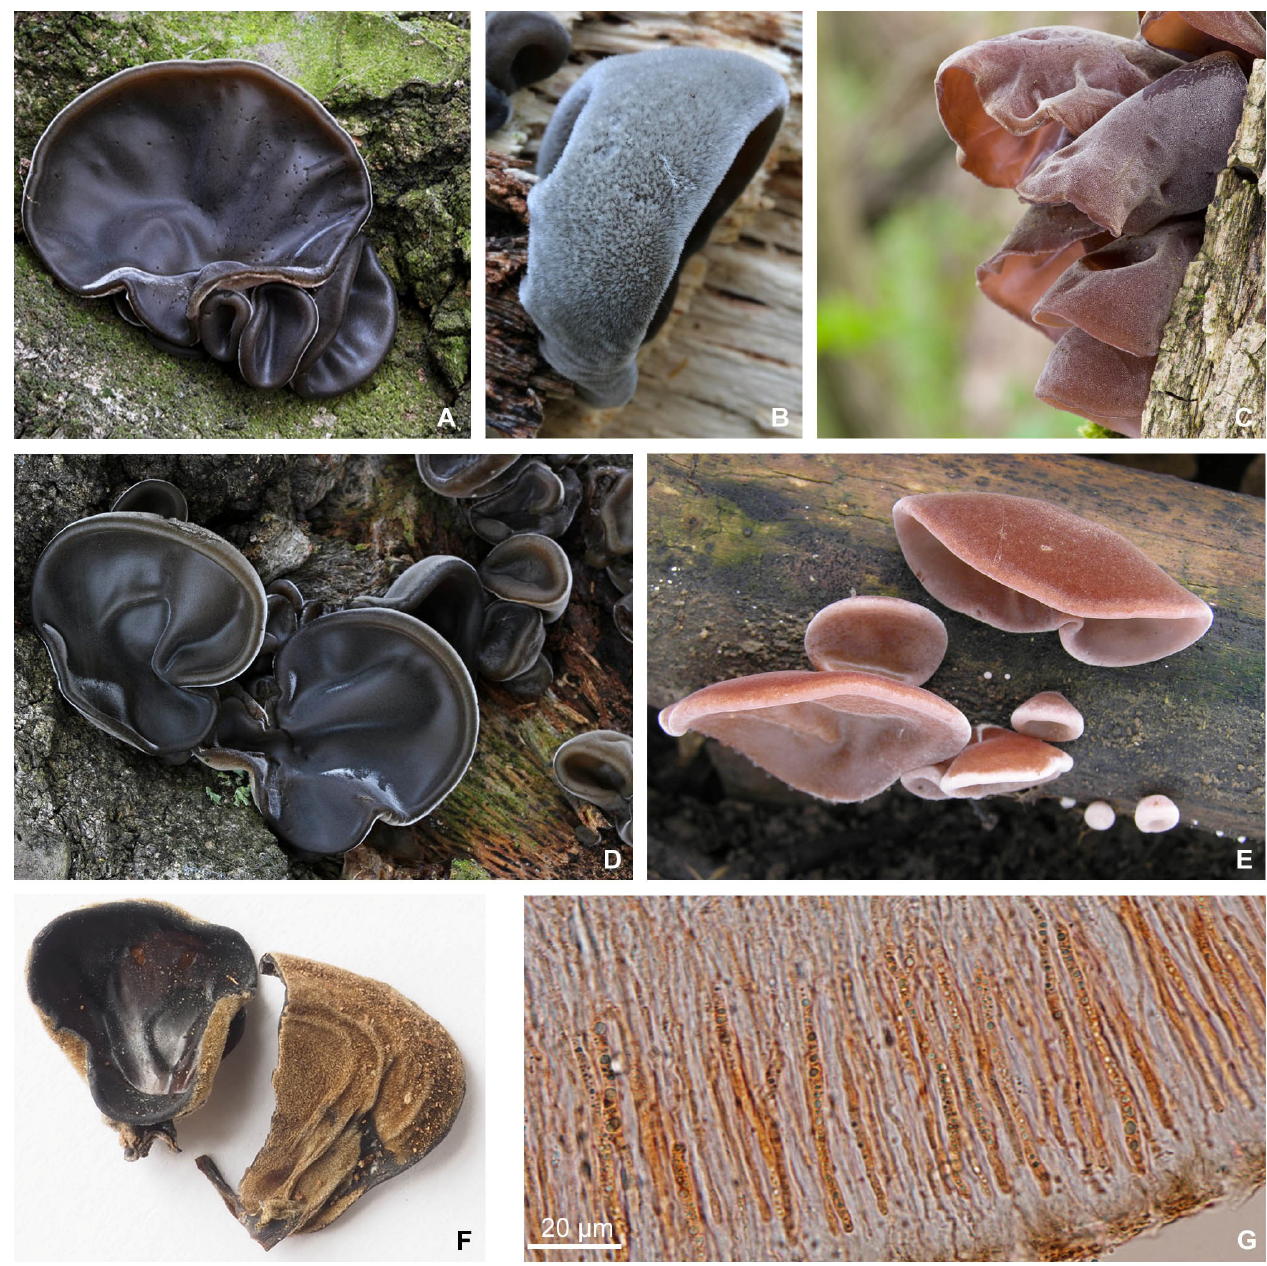
Figure 3. Comparison of Auricularia species: ( A , B , D ) Basidiocarps of A. cerrina in field (holotype), photo L. Hejl; ( C ) A. auricula-judae in field (LZ 1804), photo L. Zíbarová; ( E ) A. auricula-judae in field (LZ 0612), photo L. Zíbarová; ( F ) Dried specimen of A. cerrina (part of holotype); ( G ) Hymenium of A. cerrina (holotype).